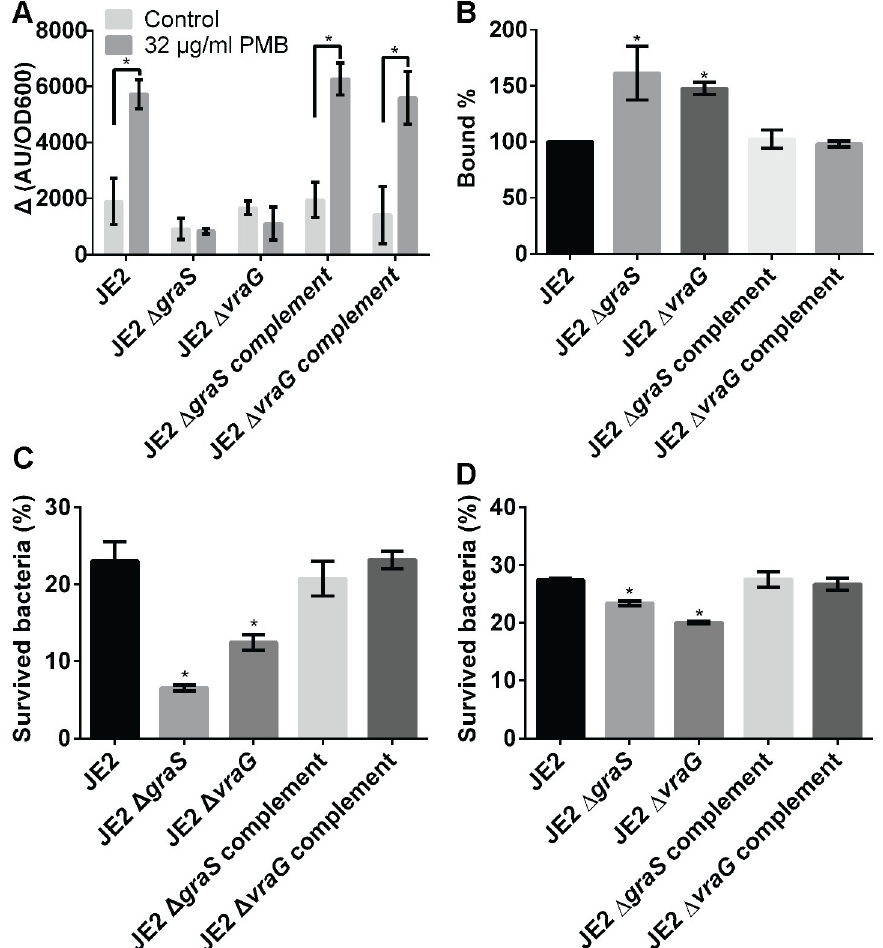
Fig 1. Δ vraG mutant phenocopies the Δ graS mutant. (A) The expression of the mprF promoter driving GFPuvr fusion upon PMB treatment. Strains with mprF -promoter fused to the GFPuvr reporter grown to mid-log phase were treated with 32 μ g/ml PMB or water (control) and incubated for additional 30 min at 37˚C. The OD600s and A.U. (a fixed gain value at 120) of the strains were measured at two time points (before and 30 min after the addition of PMB). The means (the heights of bars) and SDs (error bars) were determined from three biological replicates. � represents p < 0.05 between two samples using Student-t test. (B) Cytochrome c binding assay. Cells in mid-log phase were resuspended in 0.25 mg/ml cytochrome c solution and incubated for 10 min at room temperature. The binding values of cytochrome c were determined by subtracting unbound amount of cytochrome c in supernatants after pelleting. (C) LL-37 susceptibility assay. Cells exposed to 2.5 μ g/ml of LL-37 were incubated for 2 hr. at 37˚C and percent survival was calculated, with the inoculum set at 100%. (D) PMN assay. Opsonized cells in mid-log phase were incubated with PMN for 1 hr. at 37˚C. The bar graphs are depicted as means (the heights of bars) with standard deviations (SDs, error bars) calculated from three biological replicates. For the susceptibility assays (LL-37 and PMN assay), the survival rates of bacteria were calculated from ratios of initial and survived number of cells. The results for susceptibility assays are representative of three independent experiments. � indicates p < 0.05 against the parent strain in B, C and D . Student- t test were used to compare two samples evaluated at the same